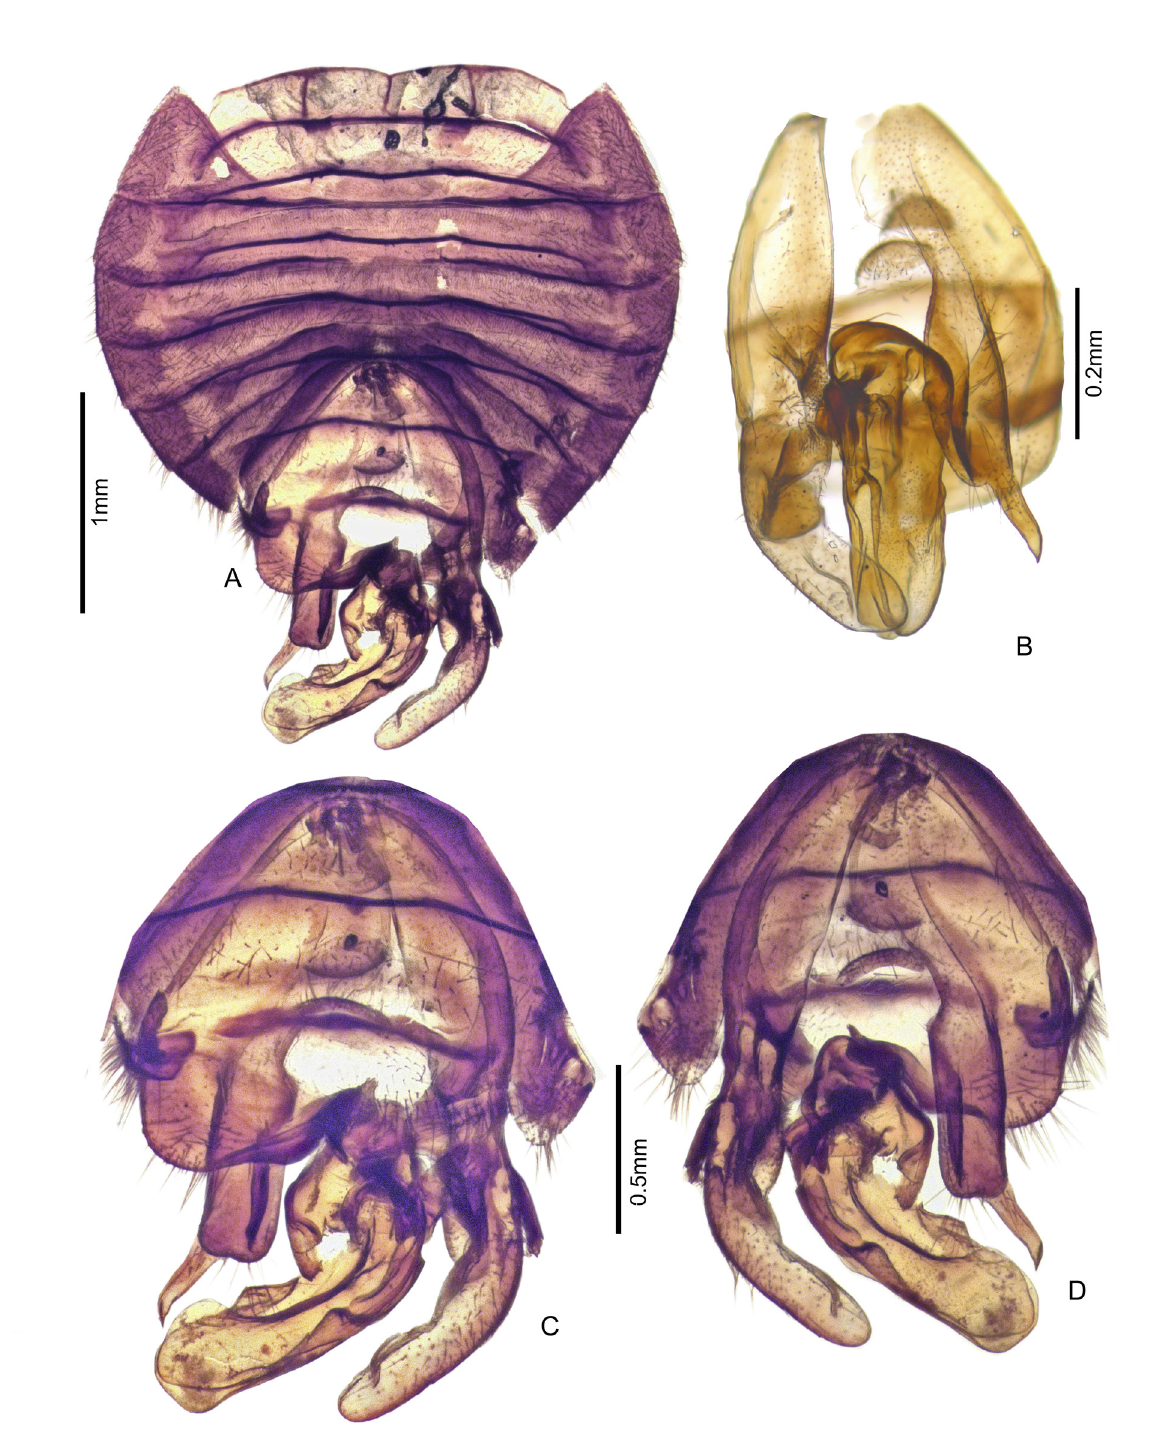
Fig. 19. Abdomen of Mertila rubrocephala sp. nov.,♂, holotype, UASB. A . Abdomen in dorsal view. B . Genital capsule in ventral view. C–D . Apex of abdomen in dorsal and ventral